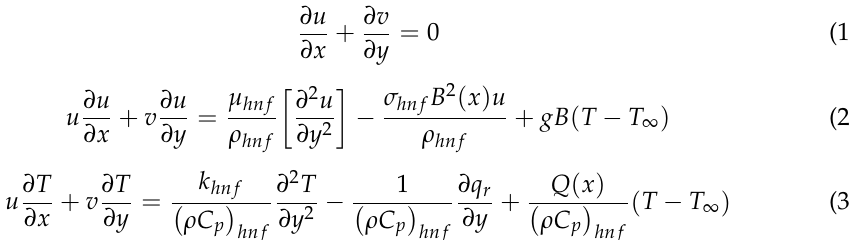
Figure 1. MHD flow and heat transfer of hybrid nanofluid over permeable exponentially shrinking sheet.